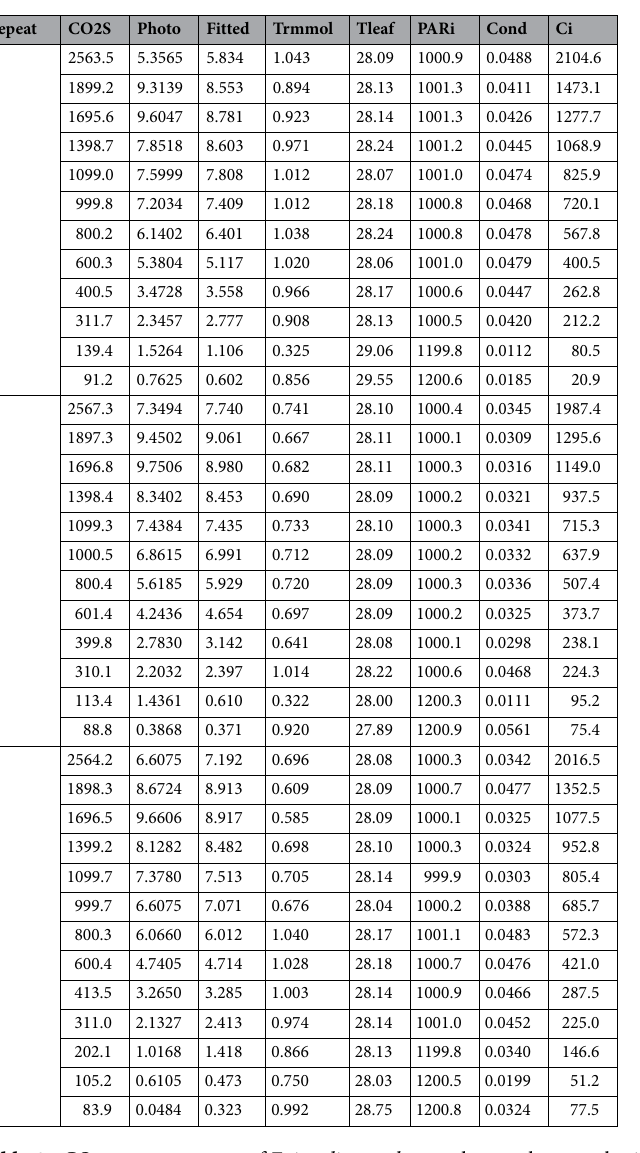
Table 4. CO 2 response curves of Epimedium pubescens leaves photosynthesis. Photo, photosynthetic rate, unit: µmol CO